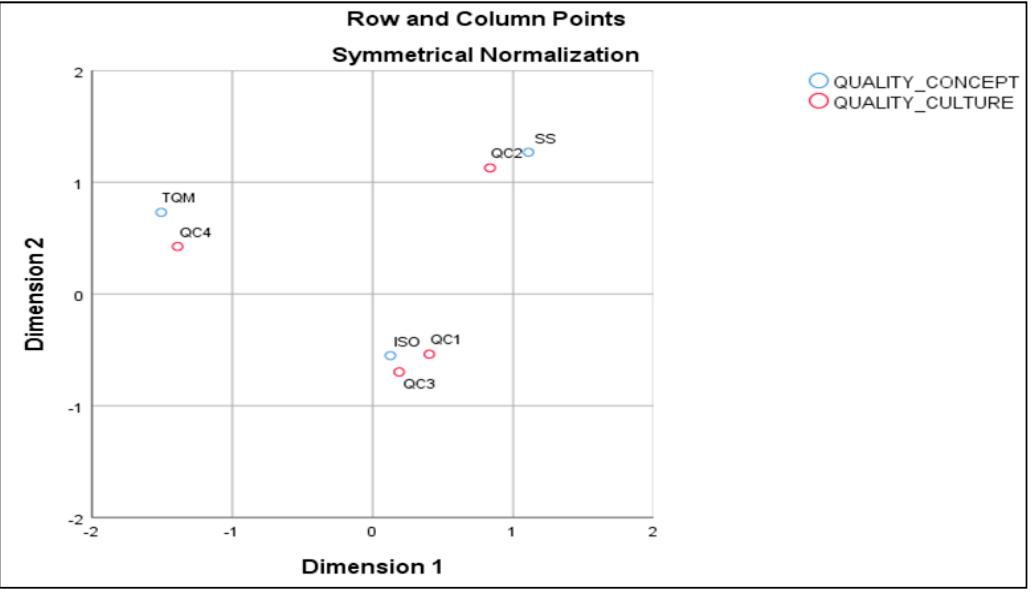
Figure 2. Common correspondence map of the quality concepts and the quality culture.